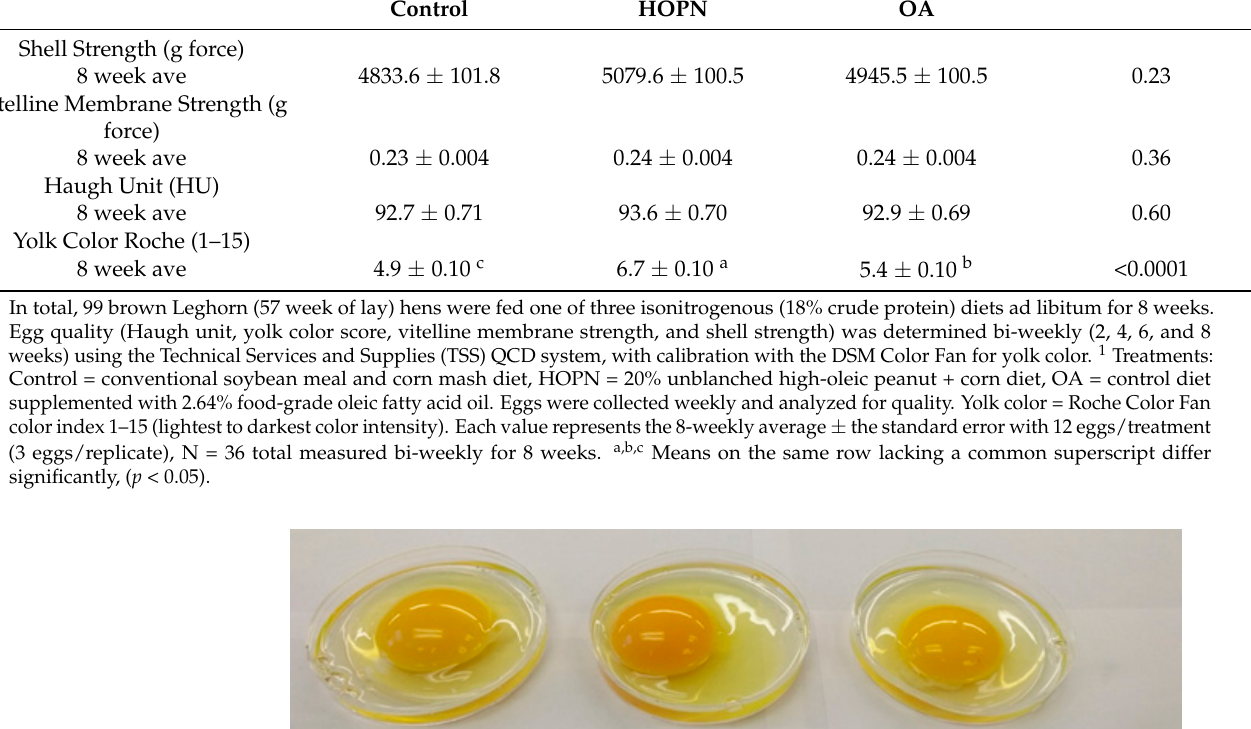
Table 4. Egg quality of eggs produced from laying hens fed a diet of high-oleic peanuts or oleic acid. Item